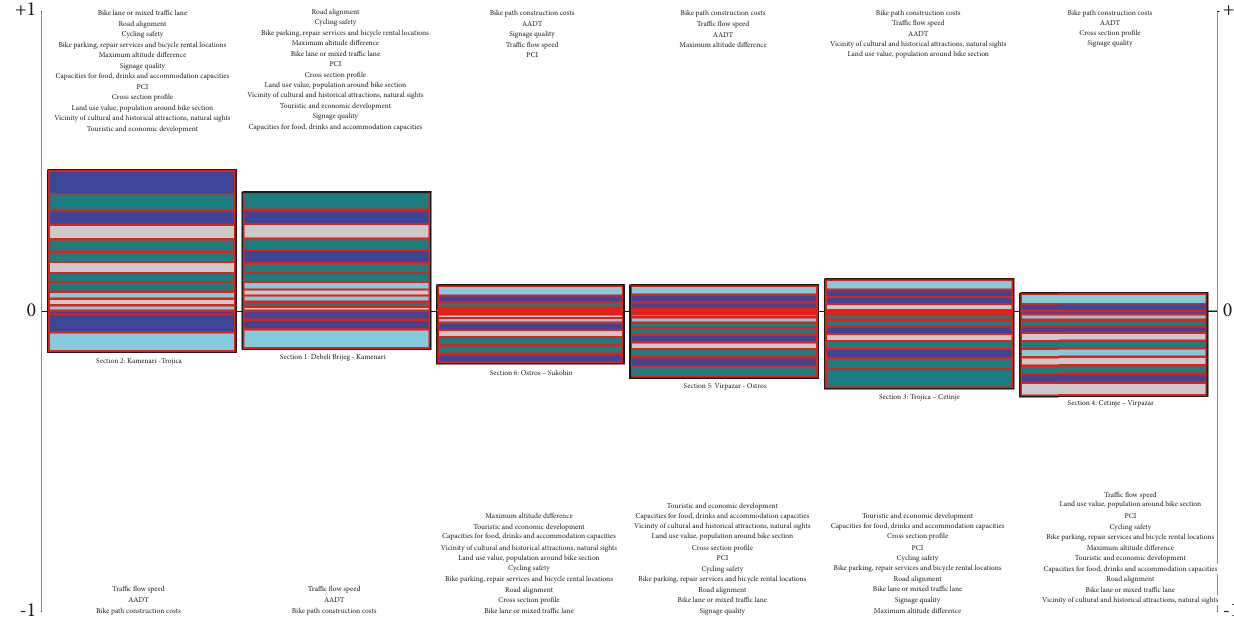
Figure 3: Promethee rainbow for all sections of EuroVelo 8 route through